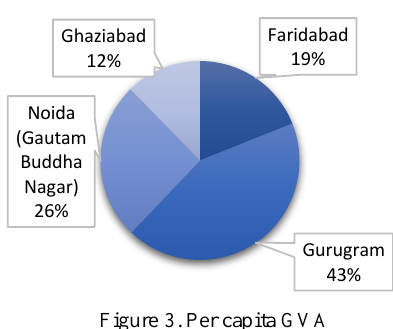
Figure 3. Per capita